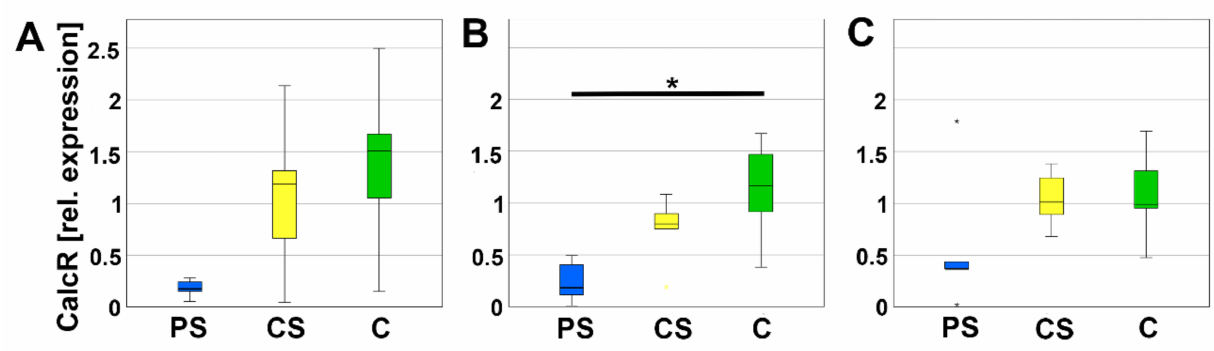
Figure 8. Relative expression of CalcR after 4 ( A ), 8 ( B ), and 12 days ( C ). * indicates a statistically significant likelihood of p ≤ 0.05. Small asterisks denote outliers.